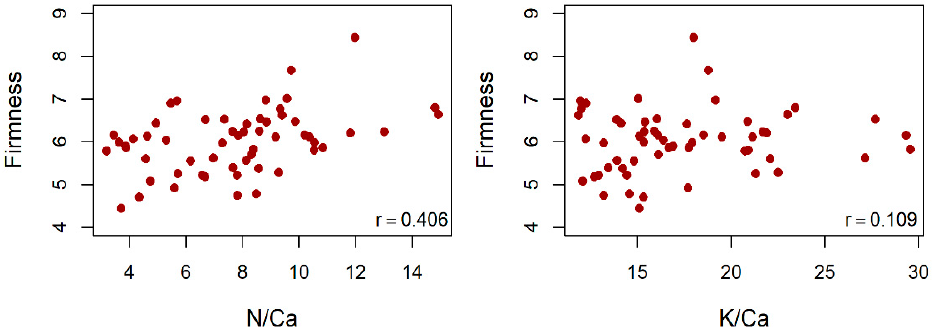
Figure 6. Firmness versus ratios of nutrients in fruits. Each point corresponds to an experimental condition defined by year, orchard and fertilization strategy, with coordinates: y—average of 14 measures in different fruits and x—average of 3 measures in independent biological replicates ( n = 60). The Pearson correlation is only significant for N/Ca (r = 0.406 with p = 0.0017); for K/Ca, r = 0.109 with p = 0.422.